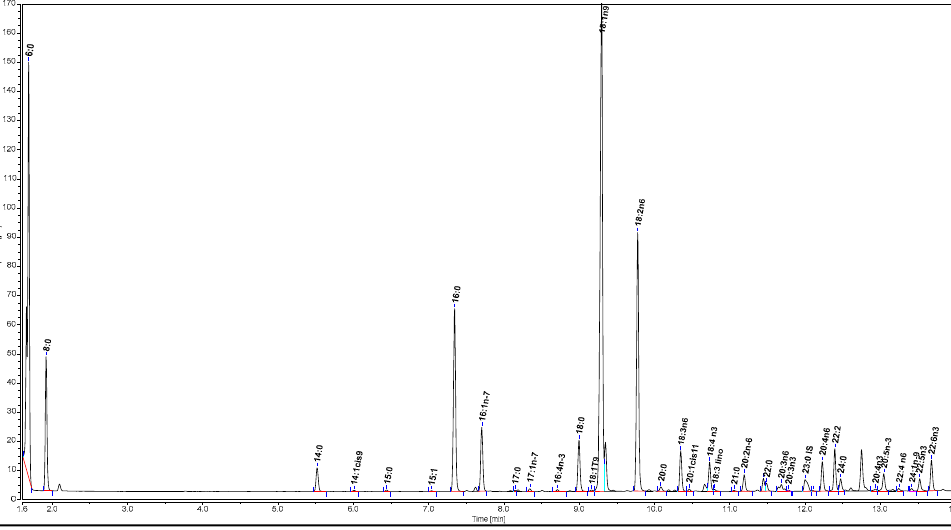
Figure 3. Gas chromatogram of biodiesel.